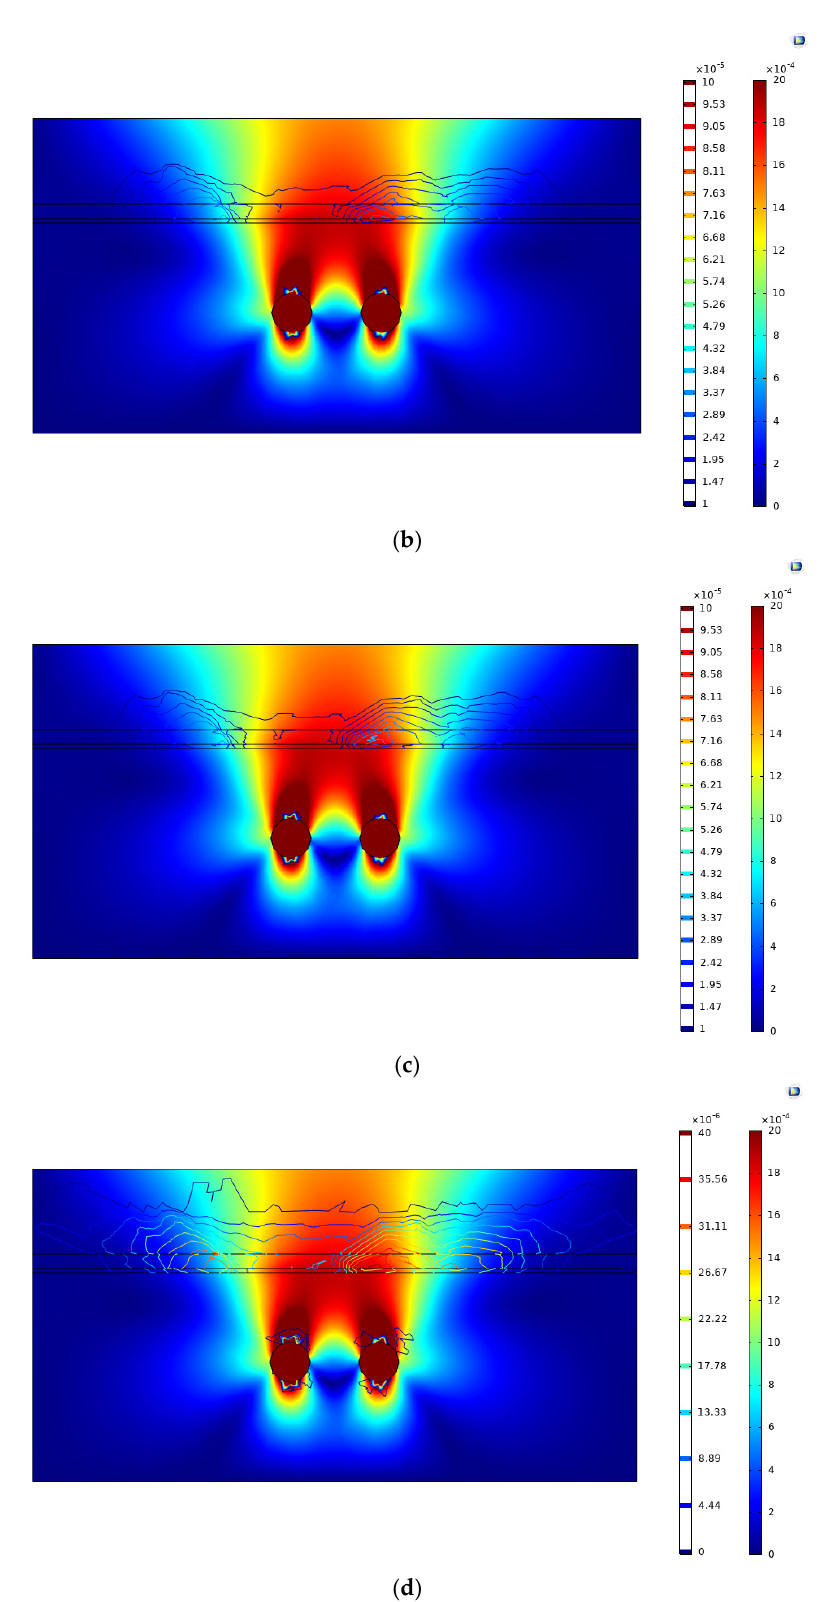
Figure 9. Contour map of plastic strain area (tunnel excavation surface spacing 0 m/25 m/50